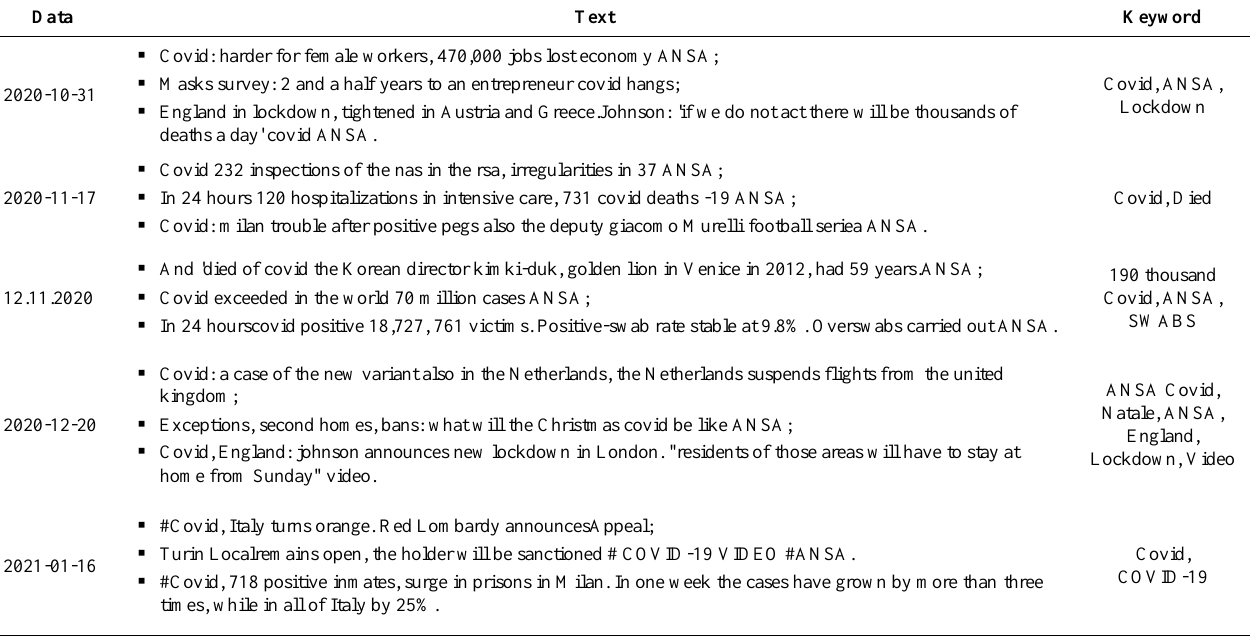
Table 7. Main news related to negative peaks